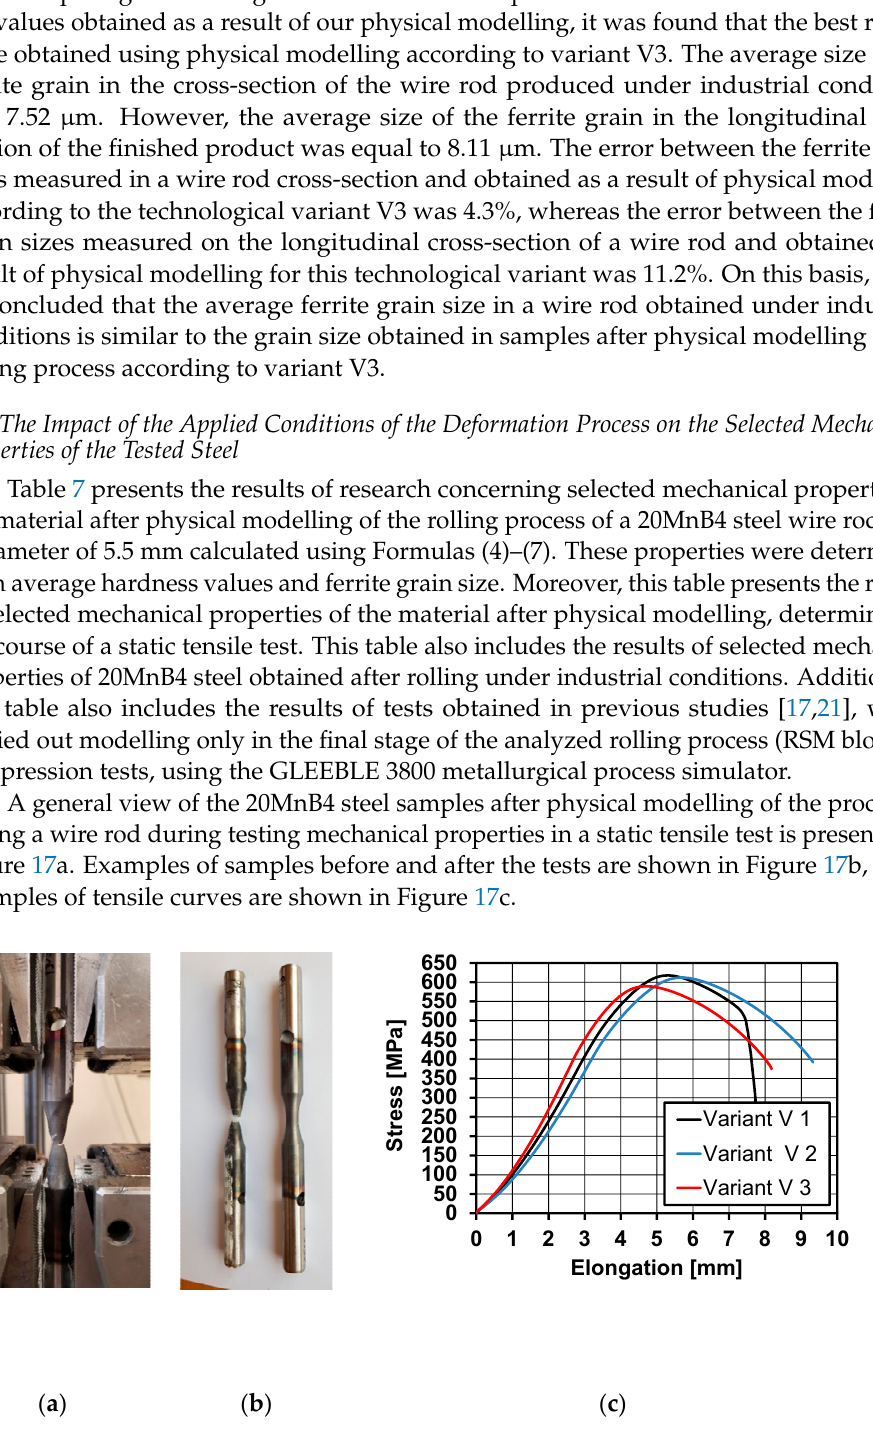
Table 7. Measurement results of selected mechanical properties of 20MnB4 steel.